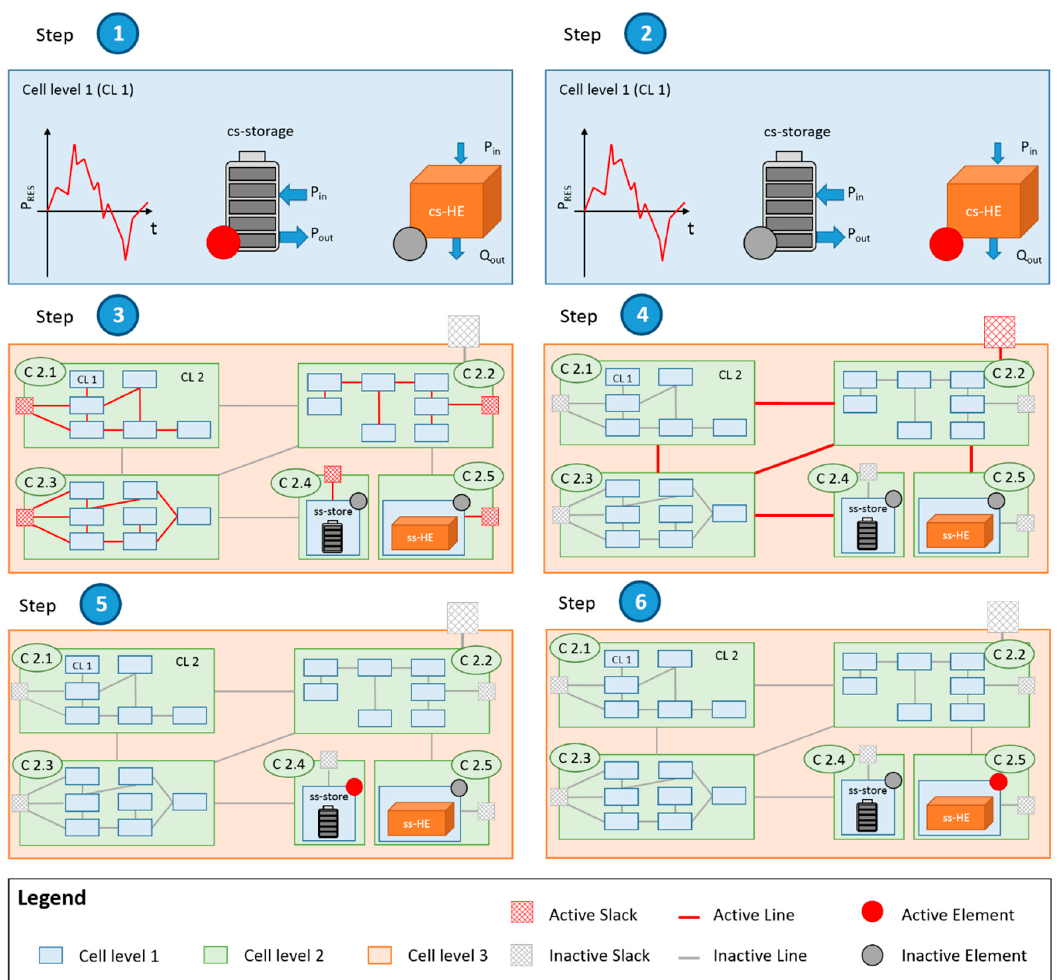
Figure 5. Illustration of the calculation process steps. All red elements are active in the calculation process.